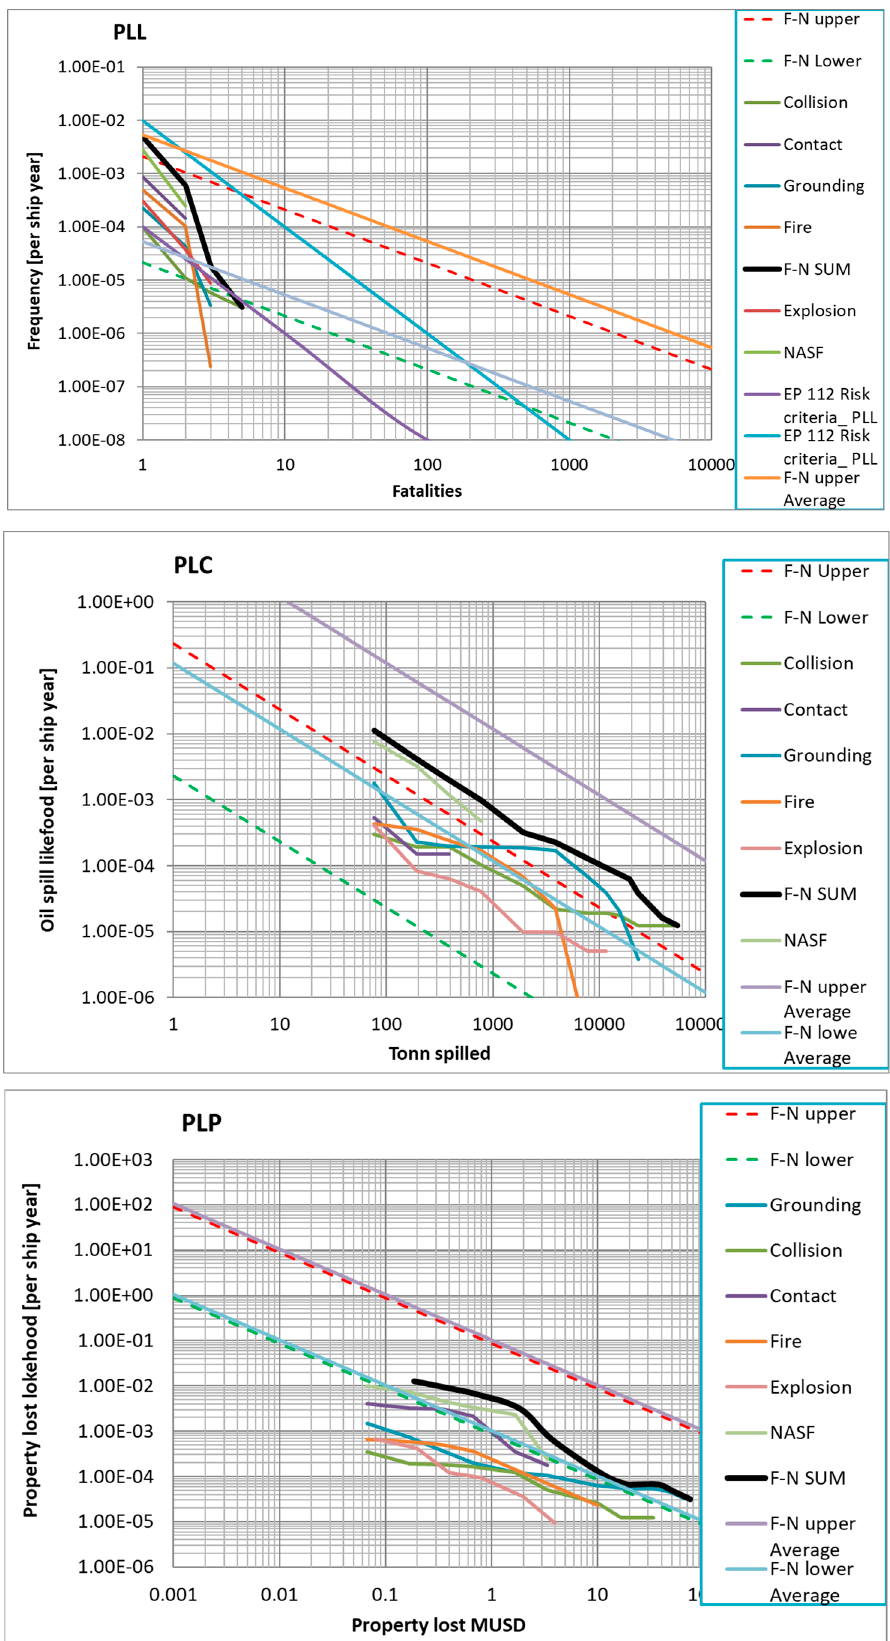
Figure 8. Overall collective risk level based on accident event.